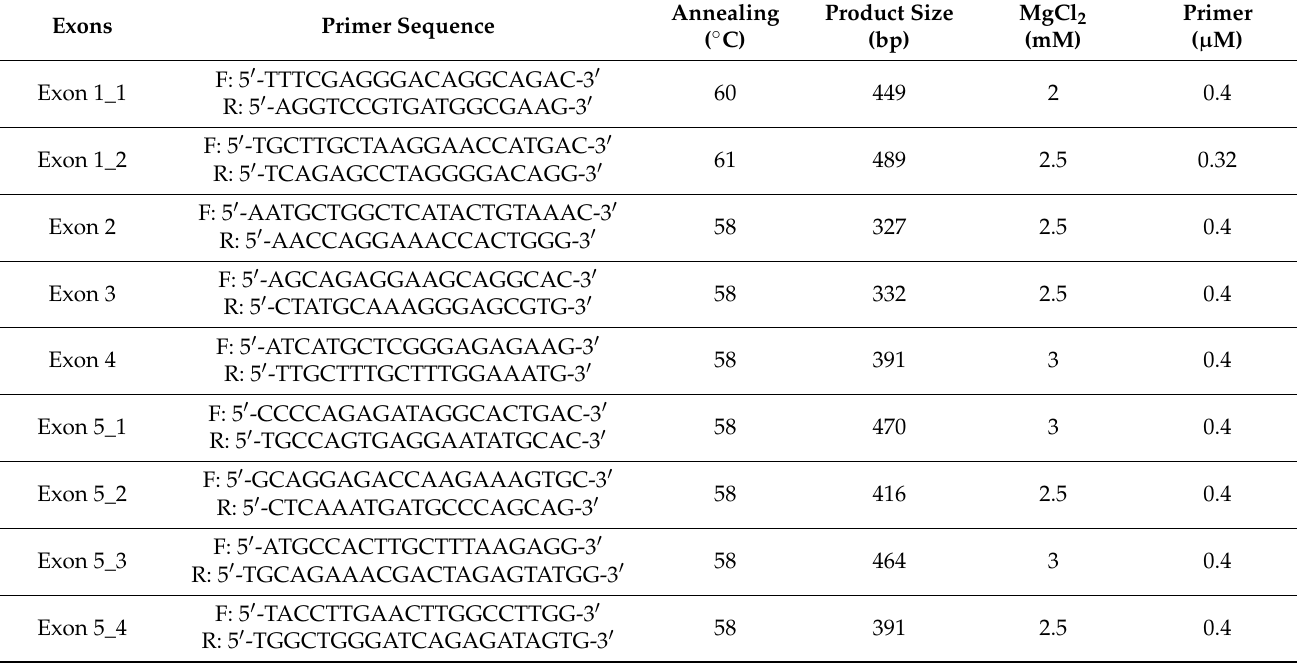
Table 1. Sequencing primers for VSX1 exons with amplification